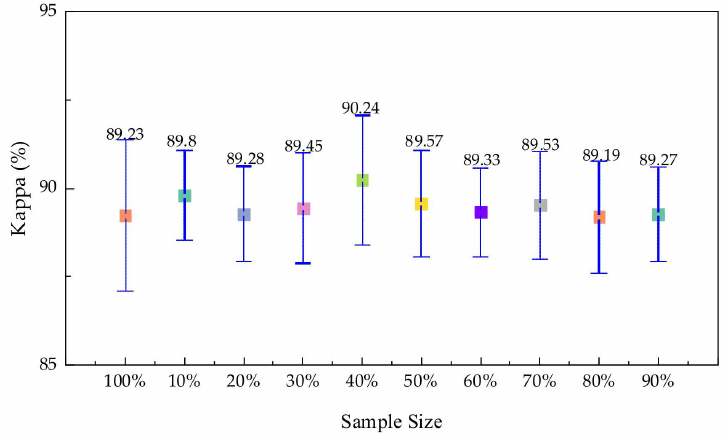
Figure 12. The Kappa and confidence intervals of SVM classifier after NKMNF with different proportion sample sizes (number of features = 45) in